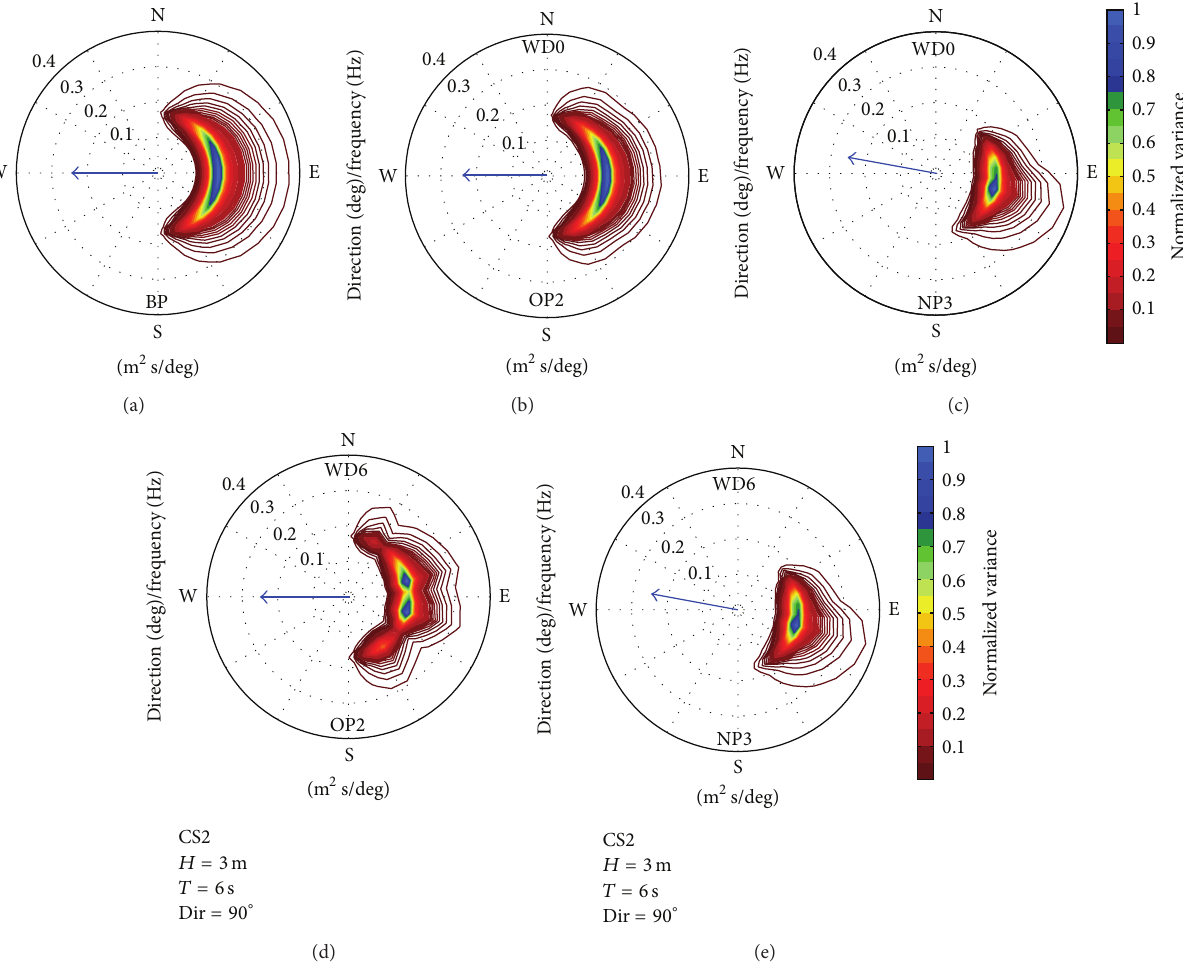
Figure 9: Evaluation in the spectral space of the impact on the wave field of a wave farm based on Wave Dragon WECs that operate in the target area for CS2. (a) BP for WD0. (b) OP2 for WD0. (c) NP3 for WD0. (d) OP2 for WD6. (e) NP3 for